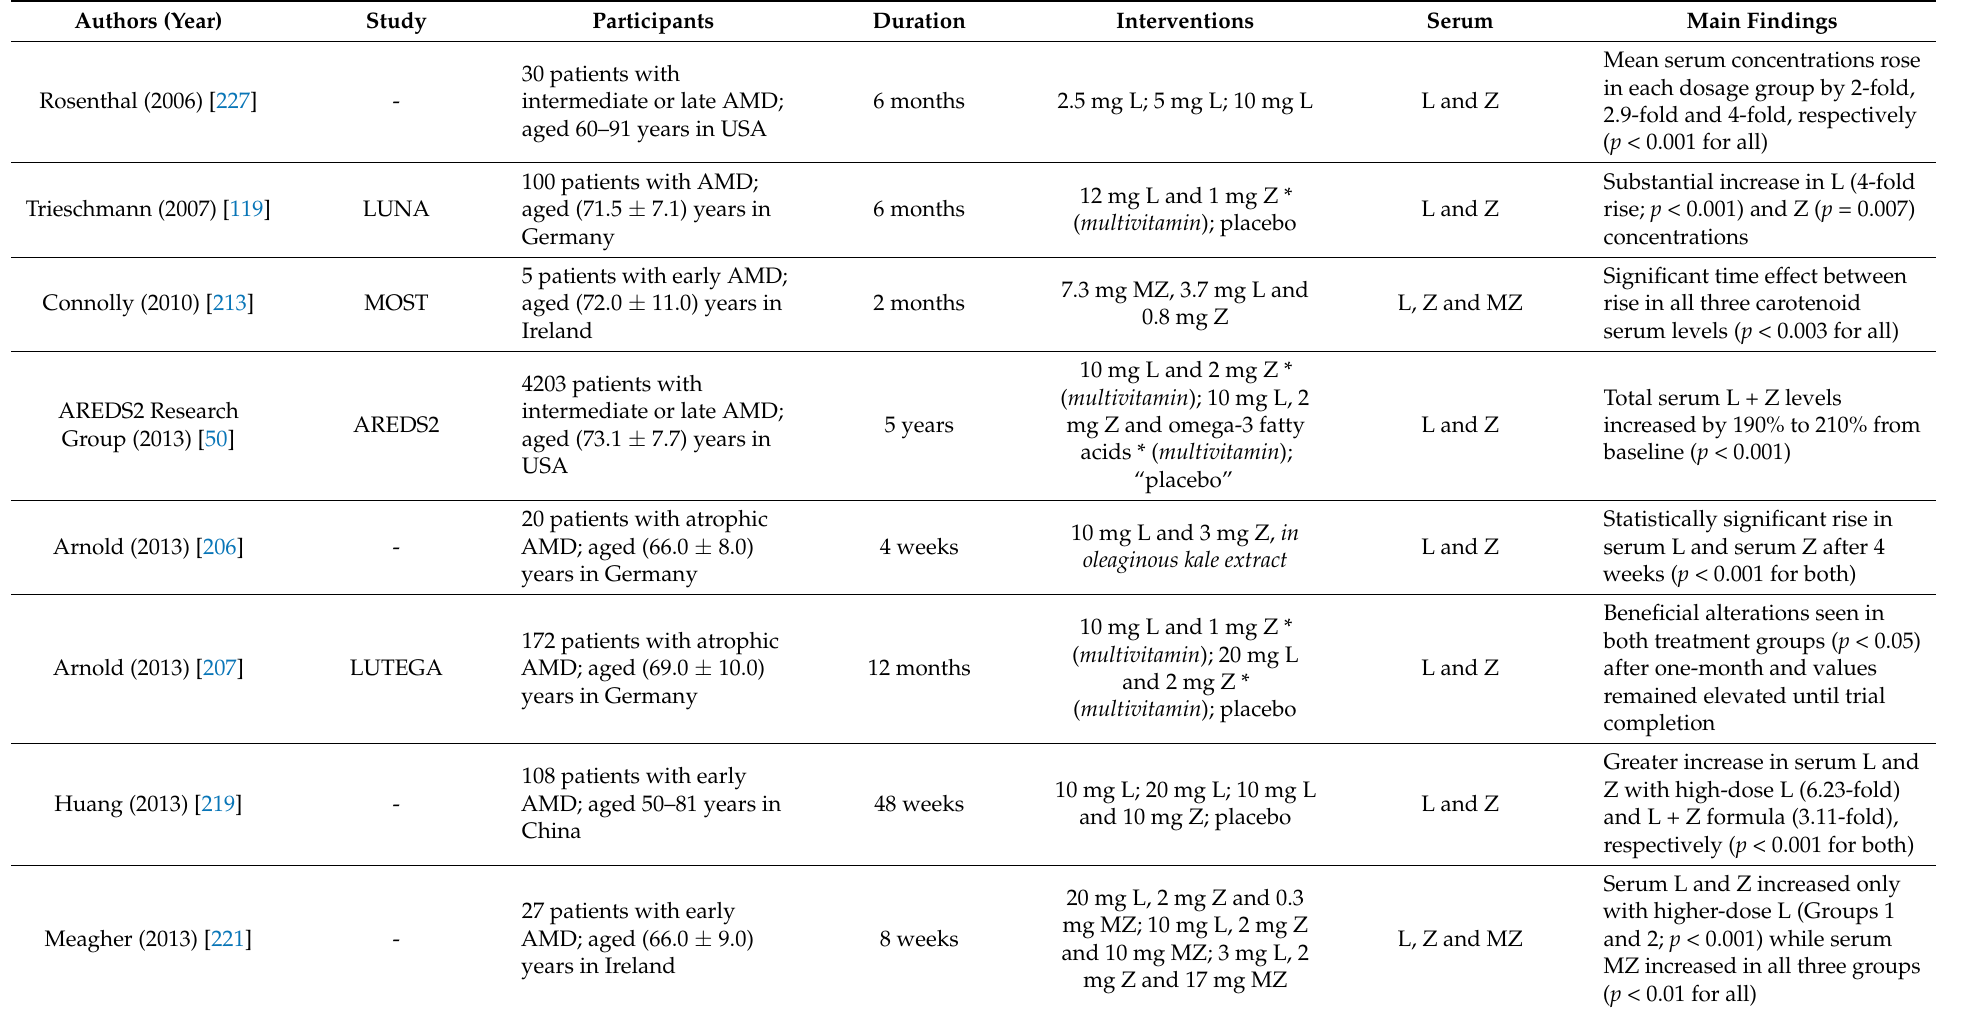
Table 4. Characteristics of the interventional studies reporting on serum carotenoid levels in